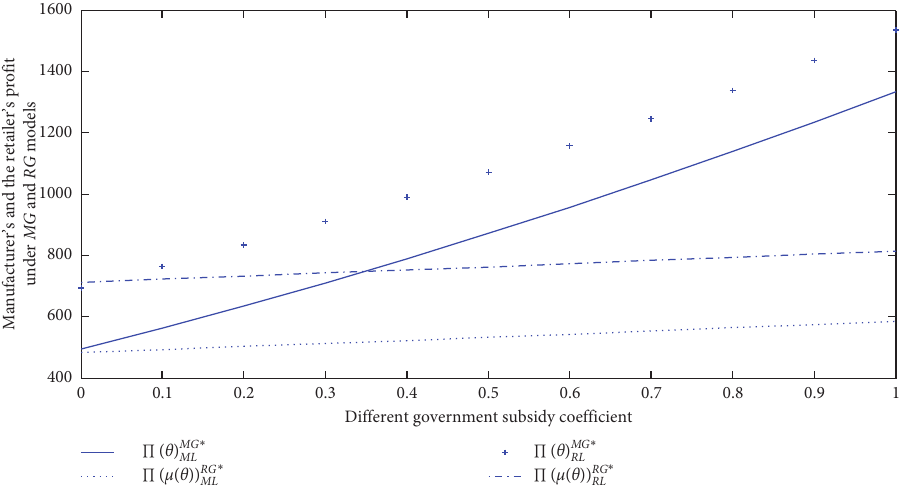
Figure 7: The impact of different government subsidy coefficients on the enterprise’s profit when the level of selling effort is